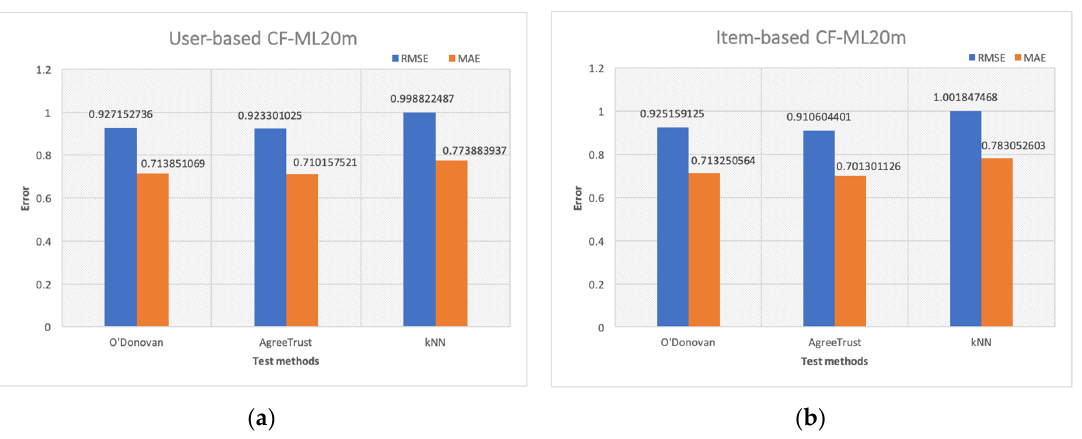
( b ) Figure 2. Result of the three CF methods for the Jester dataset: ( a ) user-based and ( b ) item-based.